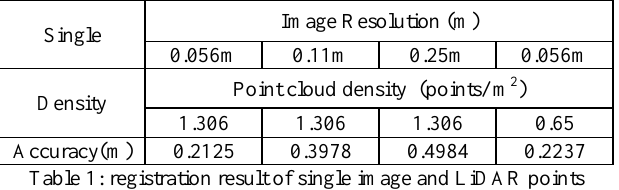
Table 1: registration result of single image and LiDAR points data (experiment 1)